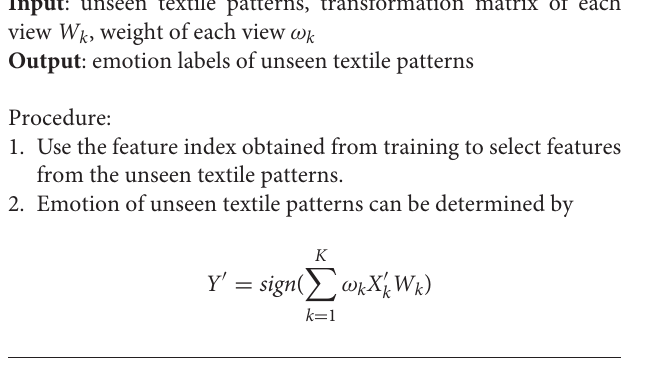
TABLE 2 | Settings of